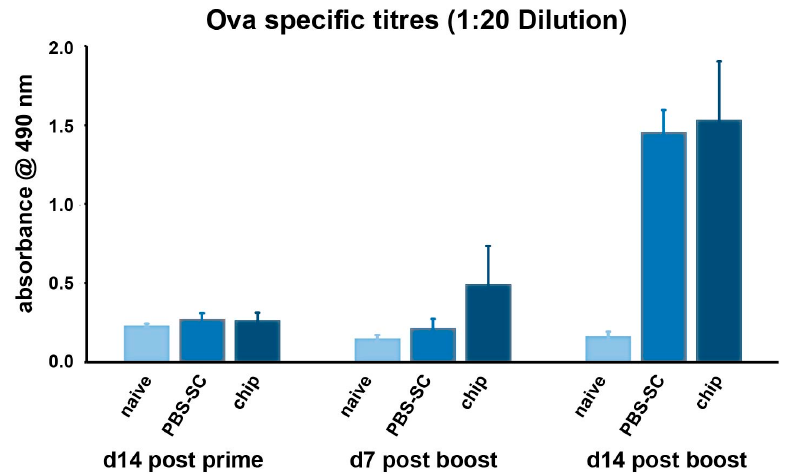
Figure 6. Ovalbumin (OVA)-specific antibody titres for mice immunized against OVA-Alum d14 after priming and d7 and d14 after booster immunization. The chip primed group had higher IgG titres at both day 7 and day 14 after the booster dose of OVA.